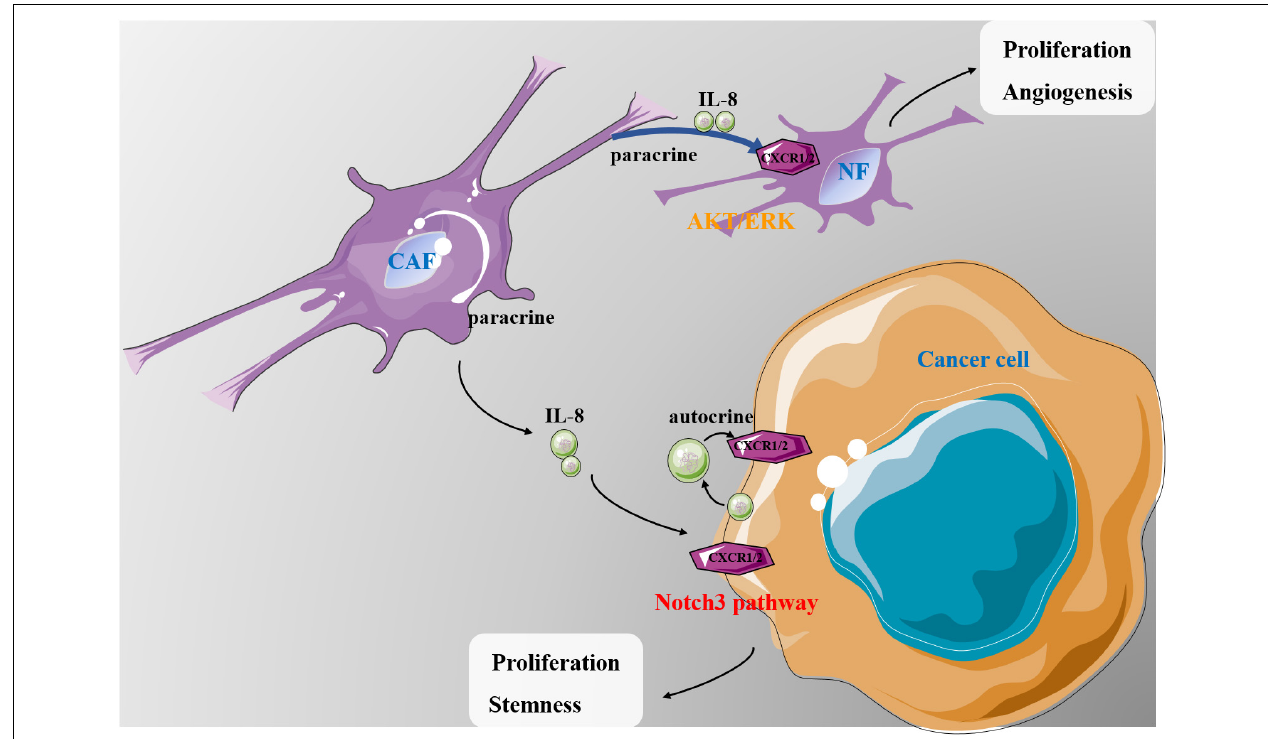
FIGURE 7 | A schematic diagram showing the possible mechanism of IL-8 in ovarian cancer microenvironment. CAF-derived IL-8 can activate the NFs in multiple signal pathways. IL-8 derived from both cancer cells and CAFs can promote proliferation and stemness of cancer cells through the Notch3-mediated signaling. IL, interleukin; CAFs, cancer-associated fibroblasts; NFs, normal ovarian fibroblasts.